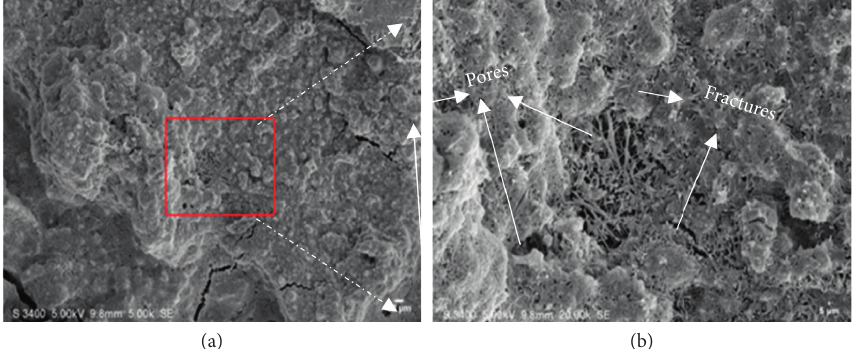
Figure 13: 120 freeze-thaw cycles. (a) SEM image of CRC. (b) Partially enlarged view of matrix cohesiveness.